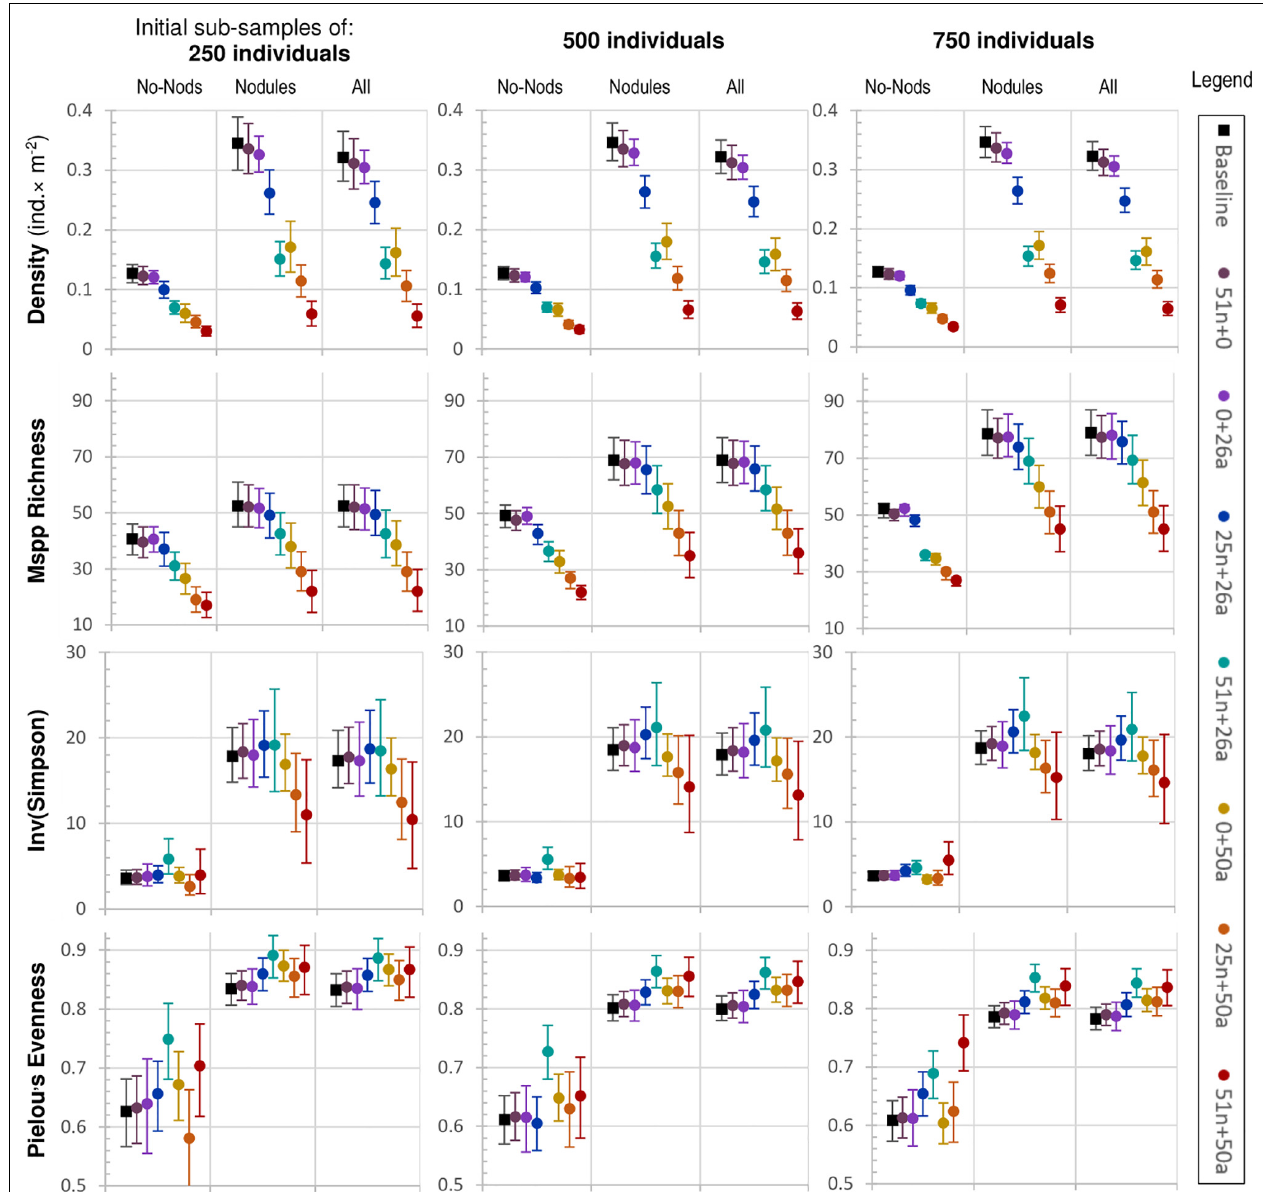
FIGURE 2 | Seven degradation treatments (plus baseline) across three sub-sample sizes (250, 500, 750 individuals), captured using four metrics: density, morphospecies richness, inverse Simpson, and Pielou’s evenness (leftmost labels). The treatment codes in the rightmost legend are explained in Table 3 . They are ordered according to increasing combined impacts left to right, violet to red. Error bars depict the 95% range of results (a proxy for confidence) over 2000 simulations. One of the treatments (25n + 0) is not displayed because in isolation it had very little impact. Sub-samples of 1000 individuals performed very, similarly, to 750 and are therefore not shown. Four additional metrics are displayed in Supplementary Figure S3